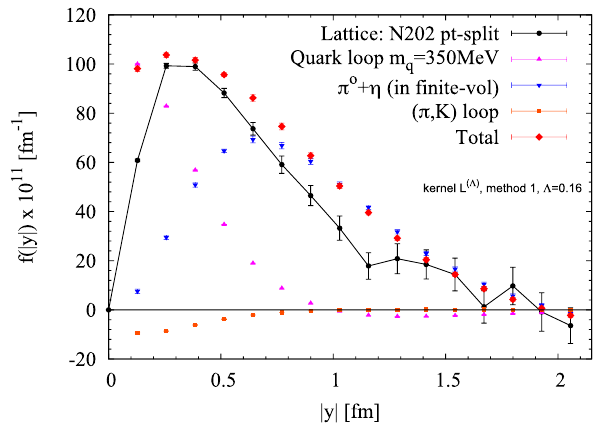
Fig. 7 Integrand for the connected contribution on ensemble N202 using method 1 with (cid:12) = 0 . 16. The lattice data use a point-split current at x . The integrand is compared to the prediction for the exchange of the π 0 and η mesons with a VMD transition form factor, which is expected to provide a good approximation to the tail. In addition, an attempt to describe the short-distance contribution with a constituent-quark loop with a quark mass of 350MeV is made